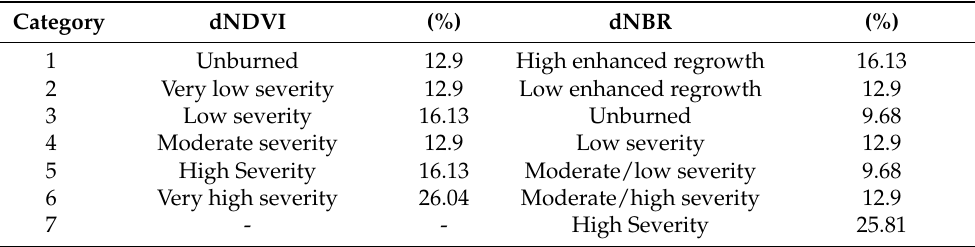
Table 5. Fire severity model validation with field data.